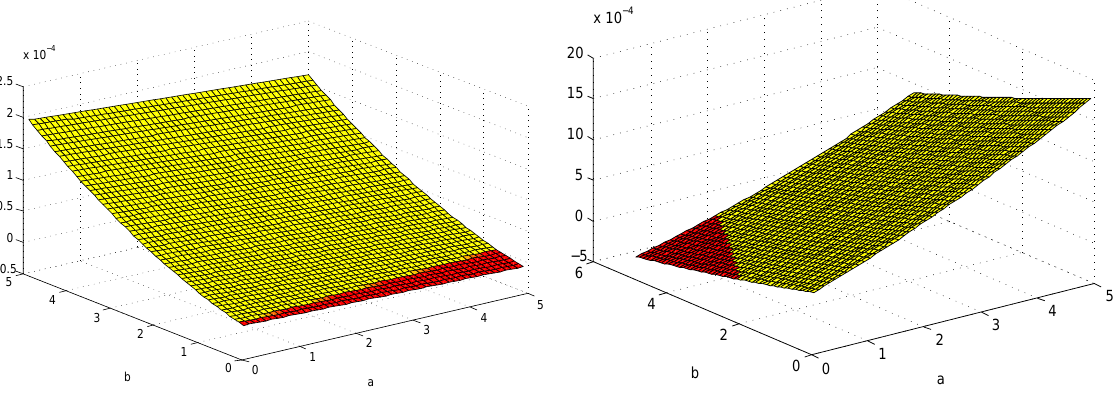
Figure 1: Difference between Bayesian and Implicit mean squared errors with respect to prior parameters a and b for σ 2 = 0 . 1 and σ 2 =